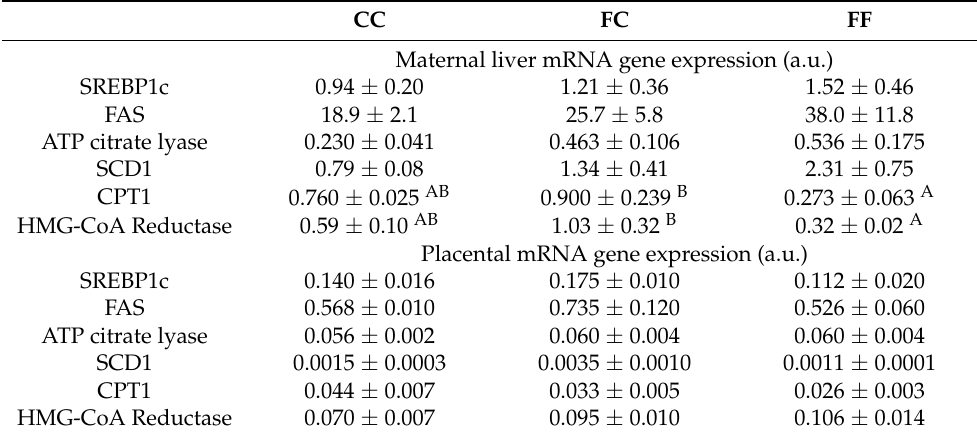
Table 2. Liver and placental gene expression in pregnant rats from fructose-fed mothers subjected (FF) or not (FC) to fructose intake throughout pregnancy and control mothers (CC). CC FC FF Maternal liver mRNA gene expression (a.u.)